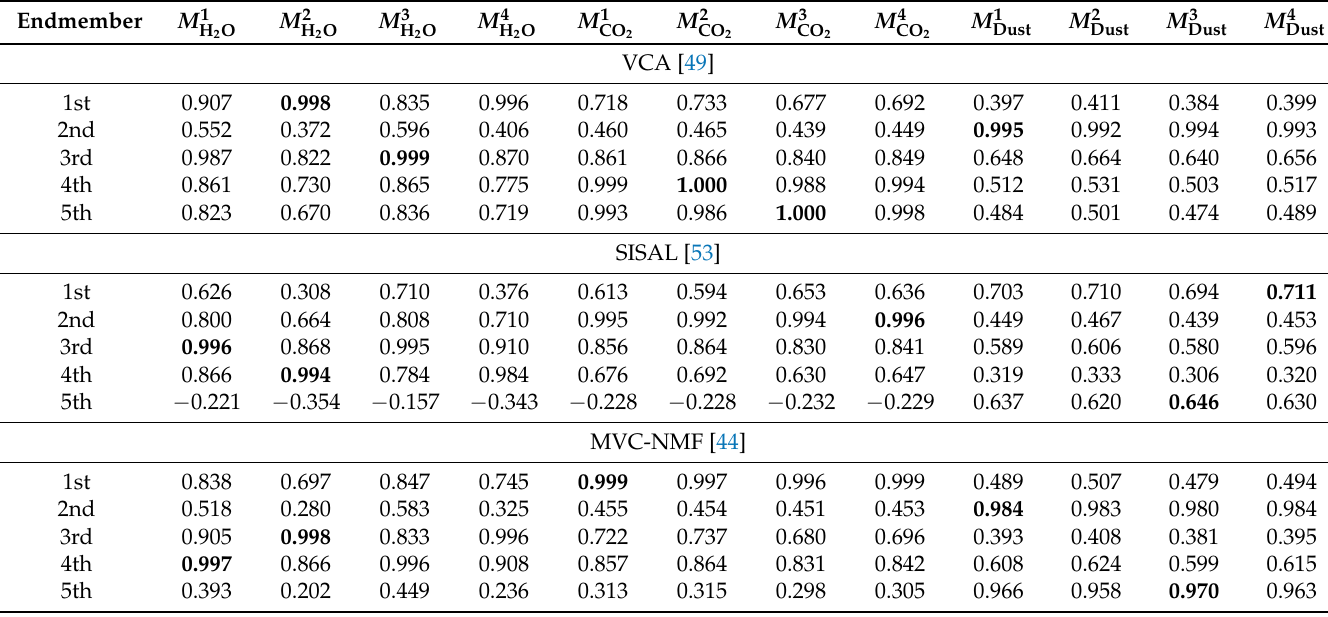
Table 7. Correlation coefficients between the extracted endmembers by the use of VCA, SISAL and MVC-NMF and the reference spectra of the endmembers under different non-linear spectral effects. A bold face stresses, in each case, the best